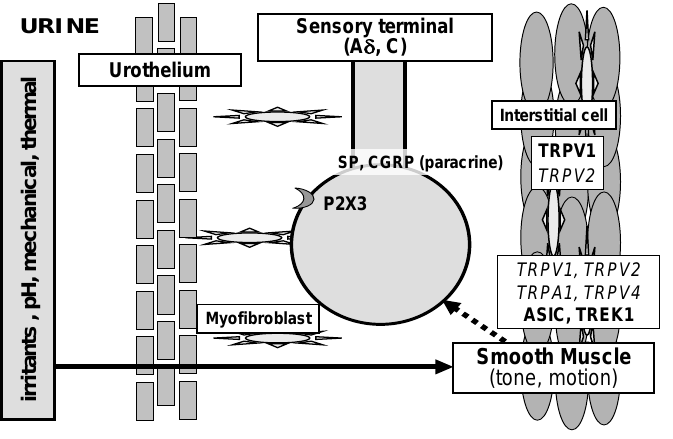
Figure 4. Possible roles of nociceptive ion channels in micromotion and tone of detrusor smooth muscle which might initiate or influence sensory nerve excitation. Italic letter indicates ion channels with weak evidence for functional